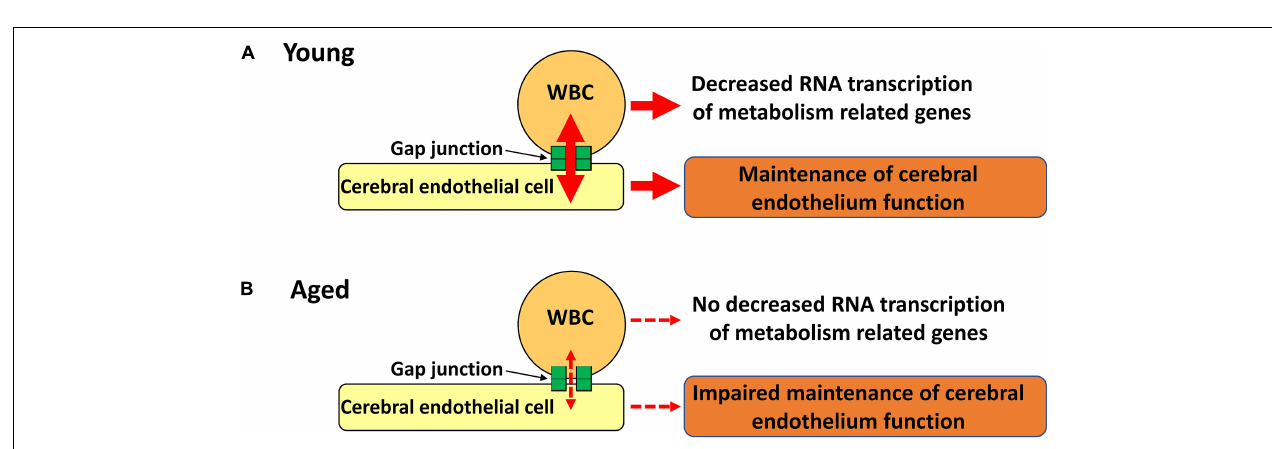
FIGURE 6 | Schematic illustration of our hypothesis. (A) Gap junction mediated cell-cell interaction between circulating WBC and endothelial cells decrease RNA transcription of metabolic related genes in WBC with maintenance of endothelial cell function. (B) Impaired gap junction mediated cell-cell interaction results in no decreased RNA transcription of metabolic related genes in WBC with impaired maintenance of endothelial cell function.